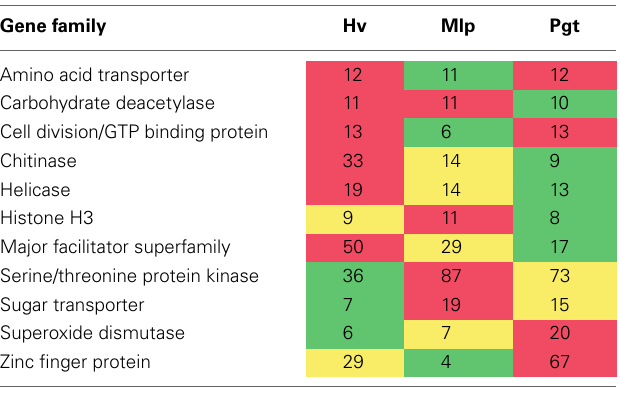
Colour scale: green to red denote lowest to highest number of genes for each gene